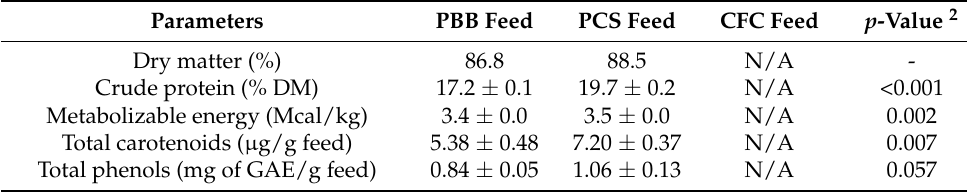
Table 1. Chemical composition and antioxidant profile of the layer hen feeds 1 . Parameters